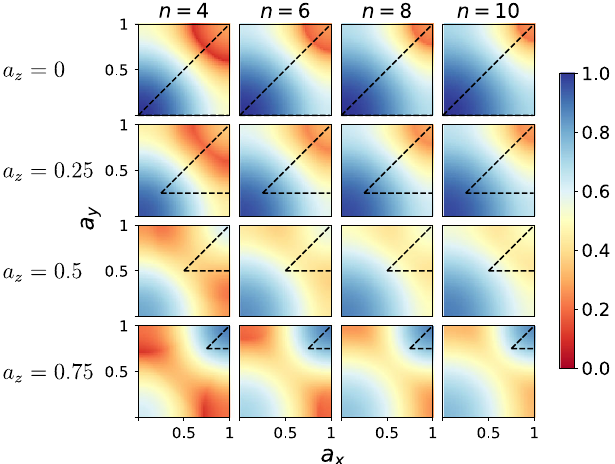
FIG. 20. Second-largest eigenvalue j λ 2 j of M for the OBC S protocol and different canonical gate parameters a [Eq. (3)]. The columns represent a fixed number of qubits, and the rows are for different a . The dotted triangles indicate the relevant set of z ; a irreducible parameters a x y